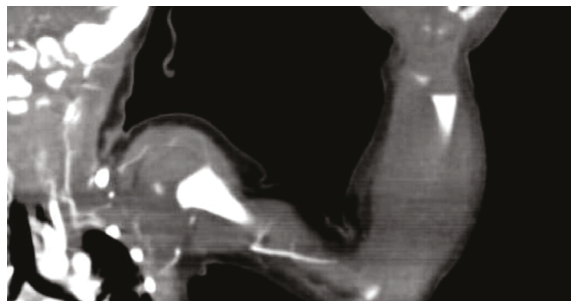
Figure 2: CTA shows a contrast filling defect in the left subclavian artery, starting about 2cm from the origin of the aortic arch as a result of left subclavian artery thrombosis.